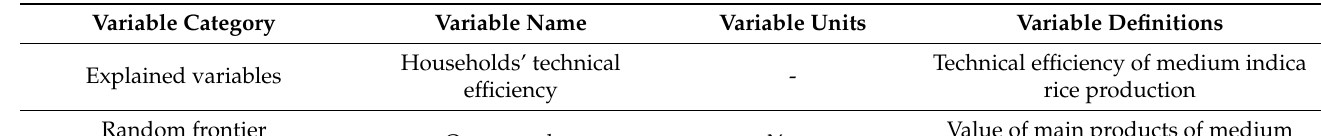
Table 1. Description of model variables for the effect of farmland transfer on the technical efficiency of farm